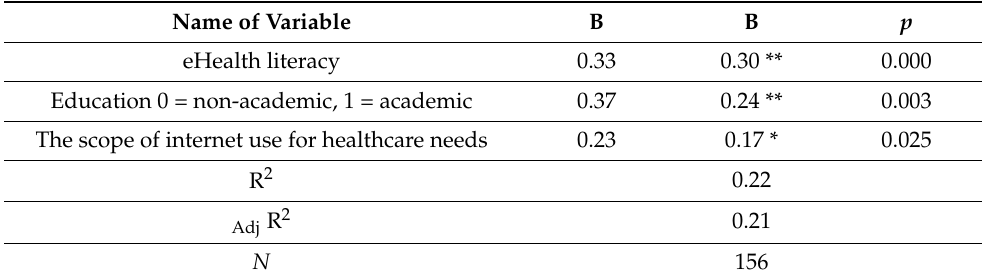
Table 3. Linear regression models for forecasting satisfaction with telemedicine. Name of Variable B B p eHealth literacy 0.33 0.000 Education 0 = non-academic, 1 = academic 0.003 The scope of internet use for healthcare needs 0.23 R